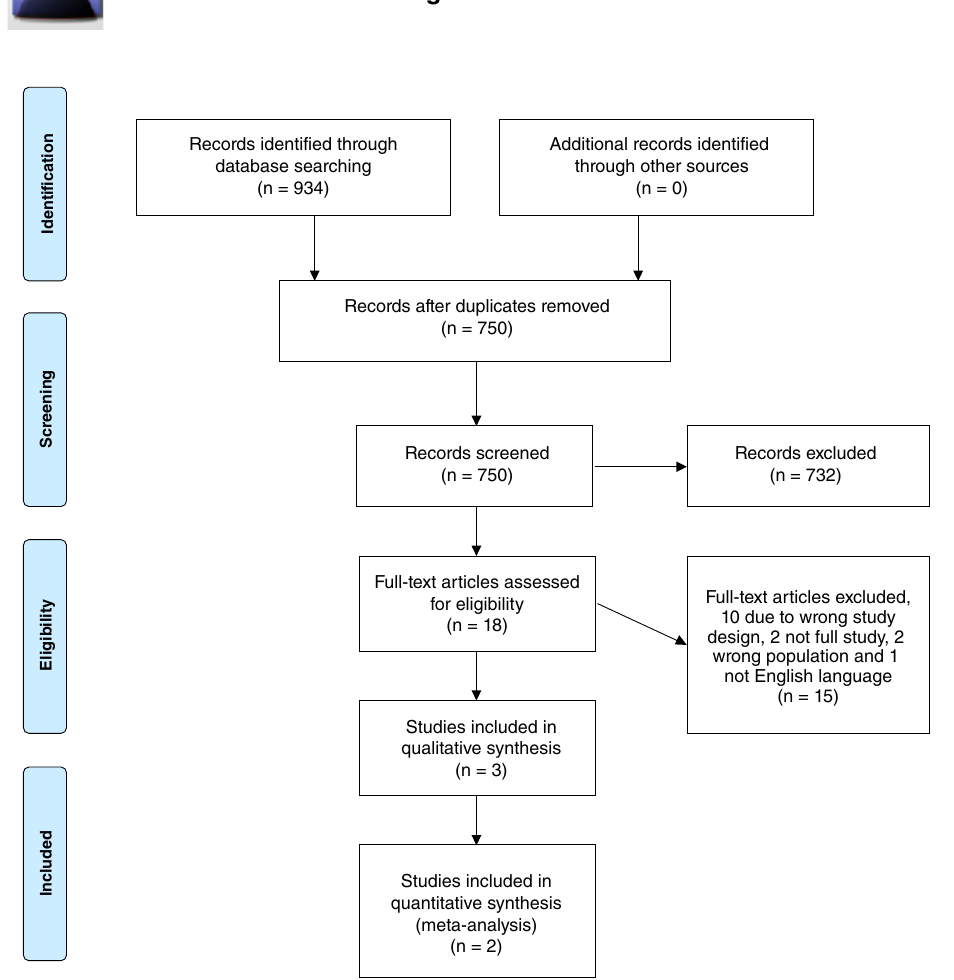
Figure 1. PRISMA flow